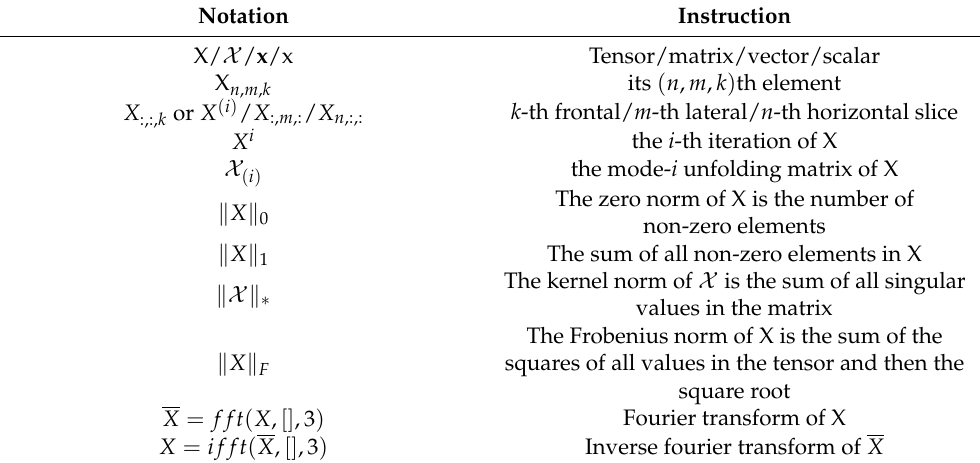
Table 1. Mathematical symbols.